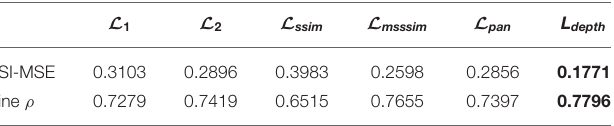
TABLE 7 | Quantitative comparison of our method with different losses on the dataset of Berman et al. (2017). L 1 L 2 L